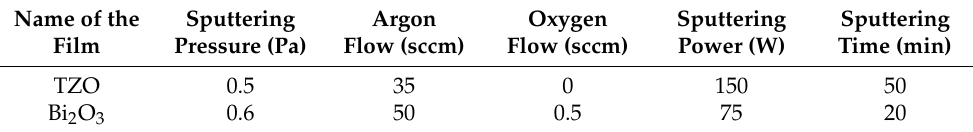
Table 1. Sputtering process parameters of TZO/Bi 2 O 3 film.